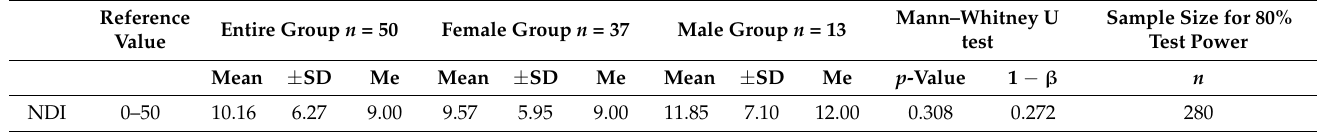
Table 6. Cervical spine dysfunction with respect to the NDI questionnaire in the study group ( n = 50) and for the group of females ( n = 37) and males ( n = 13). Mean standard deviation ( ± SD) and median (Me) are given.